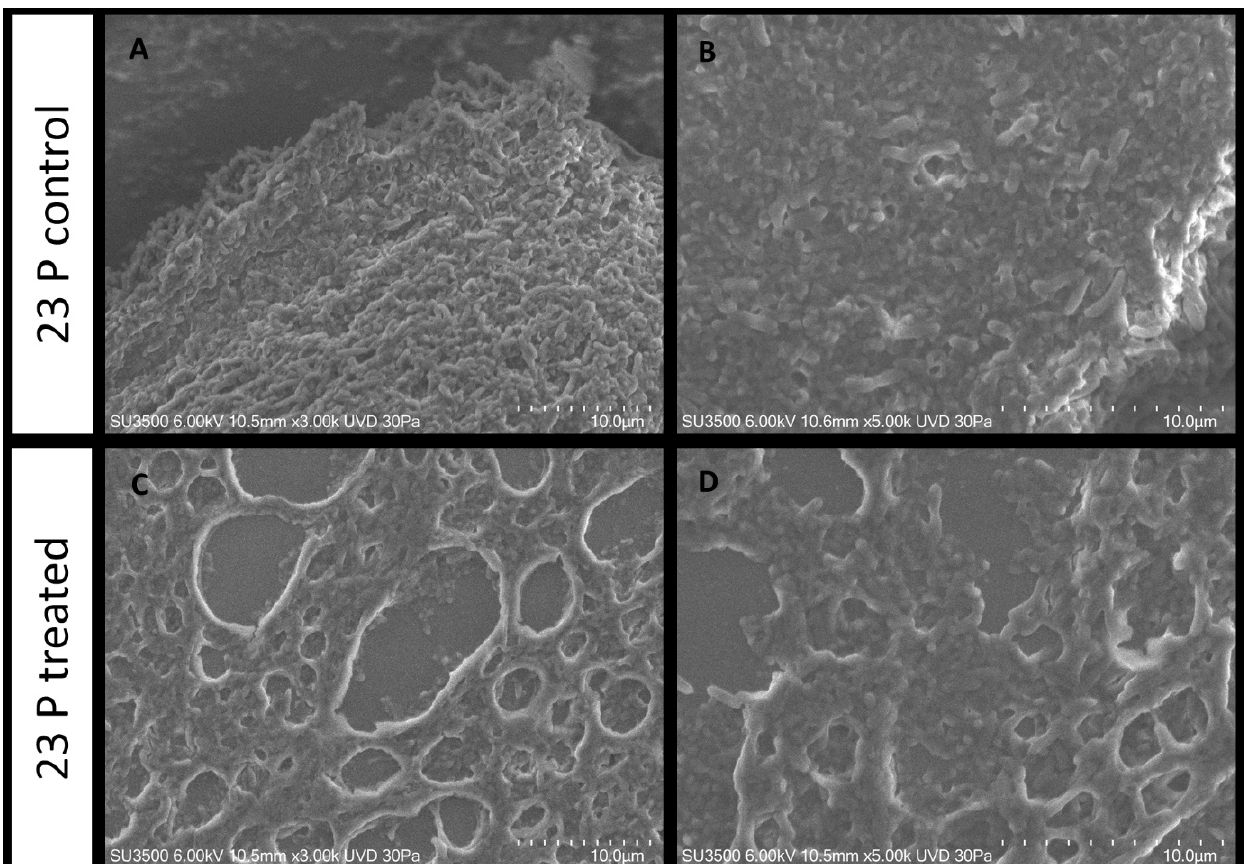
Figure 7. P. aeruginosa 23 P untreated ( A , B ) and treated ( C , D ) with SN_TAE2020.VP-SEM ( A ) 3000×, biofilm appears as a dense and rough-surfaced structure; ( B ) 5000×, bacterial cells are visible on the matrix surface and entrapped in the matrix bulk; ( C ) 3000×, the treatment affects the biofilm surface, and large ladders disrupt its surface; ( D ) 5000×, image at higher magnification shows an irregularly stratified network of extracellular polymeric substances in which bacterial cells are more or less entrapped.